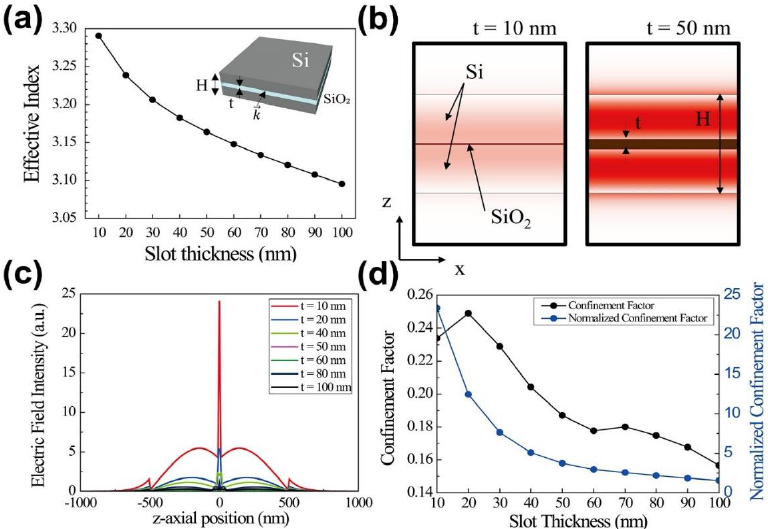
Figure 3. ( a ) Effective index of a thin SiO 2 layer embedded in a Si slab with a height ( H ) of 1000 nm as a function of the SiO 2 layer thickness. Here, 1550 nm is considered as the target wavelength; ( b ) Mode profiles of z-directional electric field intensity for the SiO 2 layer thickness ( t ) of 10 nm (left) and 50 nm (right); ( c ) Electric field intensity profiles for different SiO 2 layer thicknesses; ( d ) Confinement factor (black) and normalized confinement factor (blue) as functions of thin SiO 2 layer thickness.